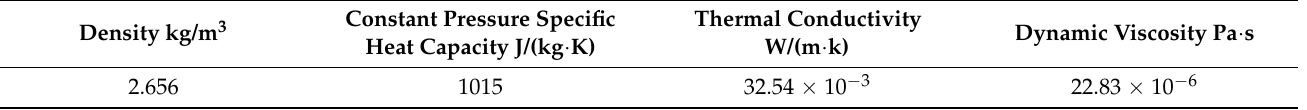
Figure 5. The dual-pass water-cooled charge air cooler. Table 3. Physical parameters of pressurized